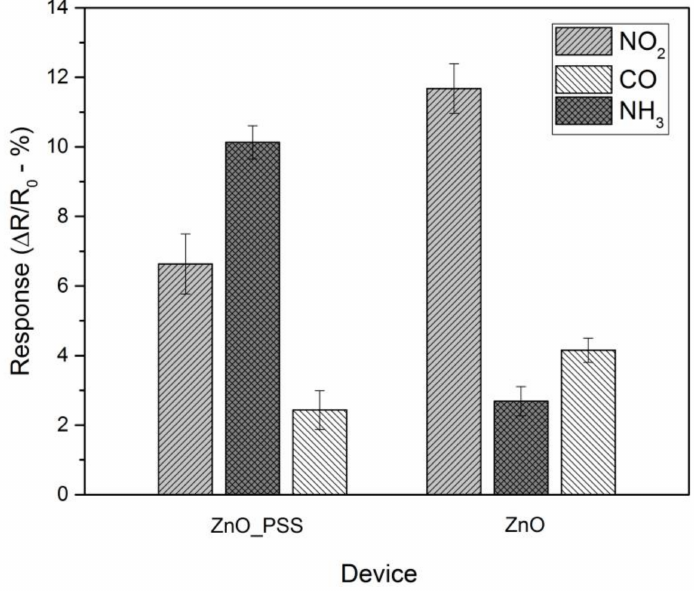
Figure 7. Selectivity study of ZnO50/PSS50 and PZnO devices upon exposure to 50 ppm of NO 2 , NH 3 and CO,